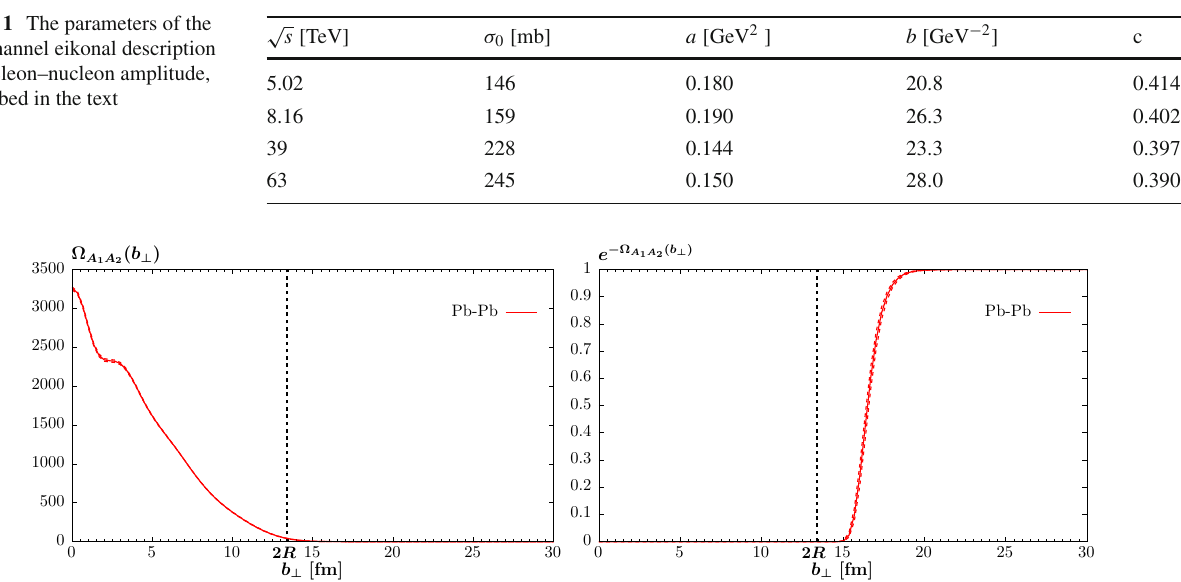
Fig. 4 Ion–ion opacity (left) and probability for no inelastic scattering (right) for lead–lead collisions, as a function of the lead impact parameter b